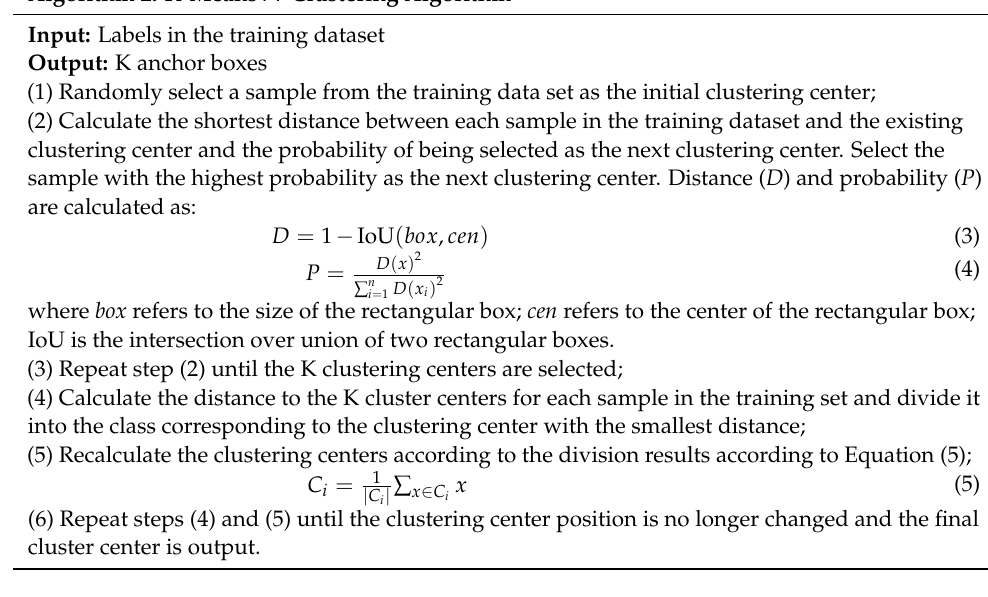
Algorithm 2: K-Means++ Clustering Algorithm